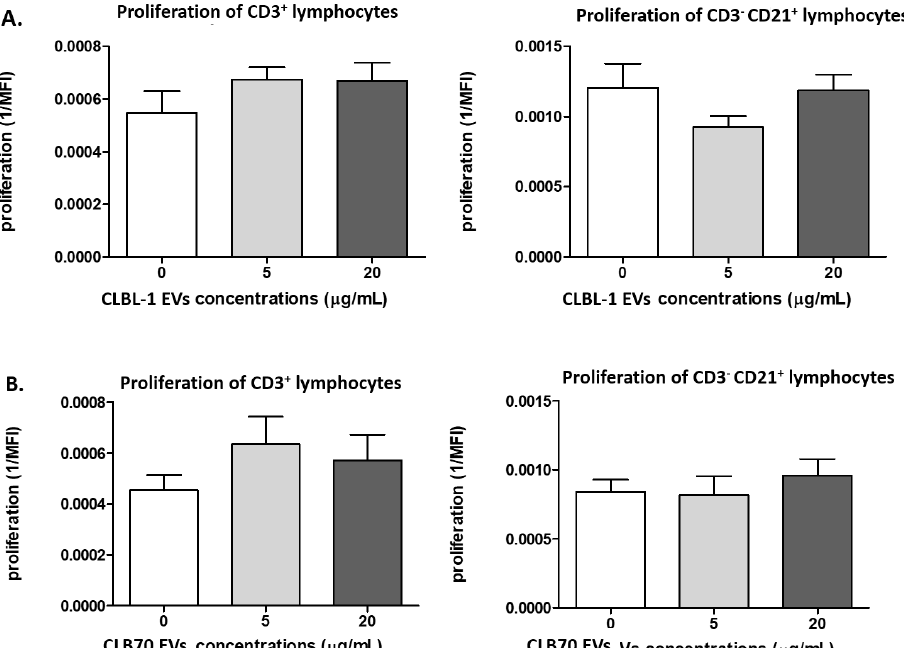
Figure 2. Influence of TEVs on the proliferation of activated lymphocytes. The figures show the proliferation intensity of CD3 + and CD3 − CD21 + lymphocytes after 5 days of culture of PBMC in a 37 °C, 5% CO 2 environment with ConA and IL-2, in the presence of CLBL-1 EVs ( A ) and CLB70 EVs ( B ) in two concentrations or without TEVs (n = 7). The results are presented as the mean ± SEM. Proliferation of Tlymphocytes (CD3 + ) in samples co-cultured with CLB70 EVs was found in the control samples (0.0004), CLB70 EVs (5 µ g/mL) (0.0006), and CLB70 EVs (20 µ g/mL) (0.0005). For B cells (CD3 − CD21 + ), proliferation was 0.0008, 0.0008, and